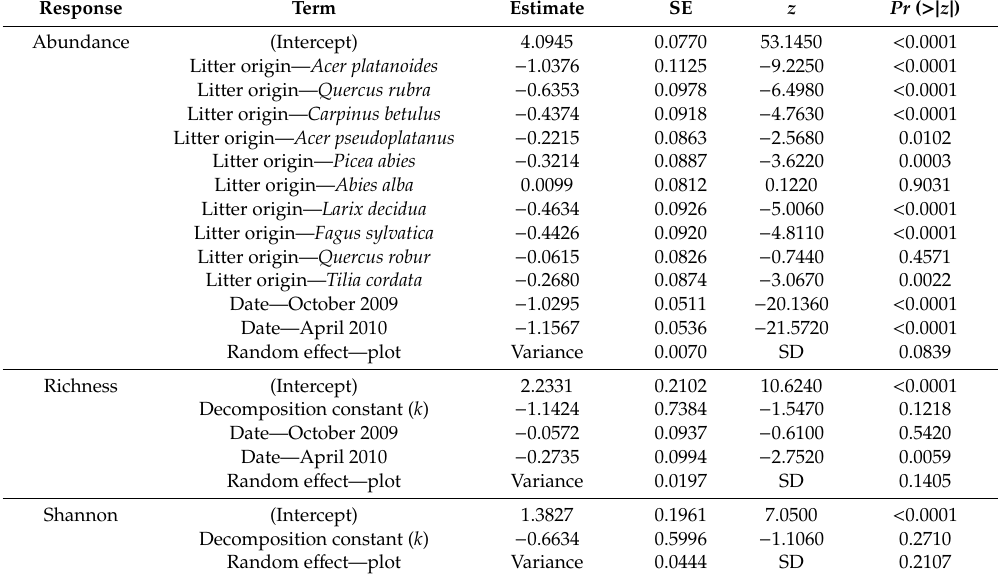
Figure 1. Mean ( + SE) species richness ( A ), diversity ( B ) and mite abundance ( C ) in litterbags. The thick horizontal line represents the mean and dashed lines represent the range of SE for the control soil mite pool at the time of experiment setup. Litter origin marked by the same letter did not differ statistically significantly ( p > 0.05), according to Tukey posteriori test. Table 1. Generalized linear mixed models explaining mite abundance, species richness, and diversity.